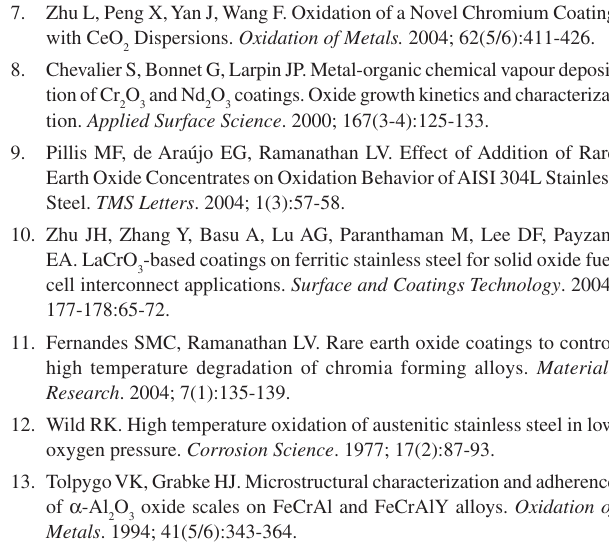
Figure 7. Cross section of Fe-20Cr-4Al after 15 cycles of oxidation in air at 1000 °C. a) uncoated; and b) LaCrO